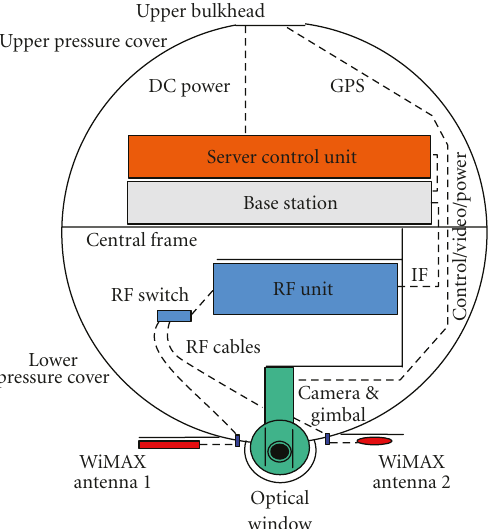
Figure 5: Derived UL modulation level (“rate”) versus HAP displacement for G = 15dBi ground antenna. Figure 6: Schematic of payload physical layout.